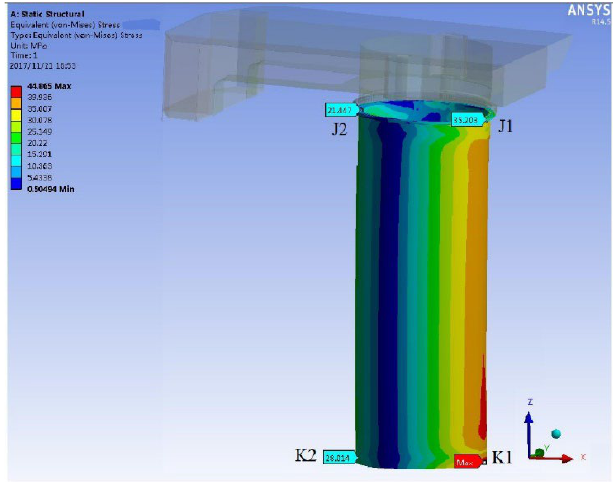
Figure 18. Analytical values of stress at each point of the cylindrical structure.